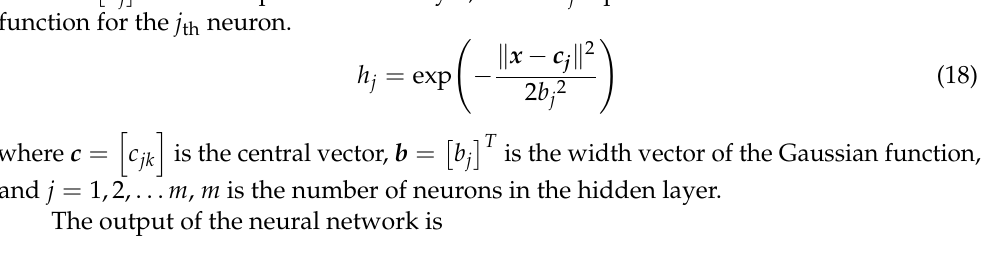
. (cid:2) e θ e p e